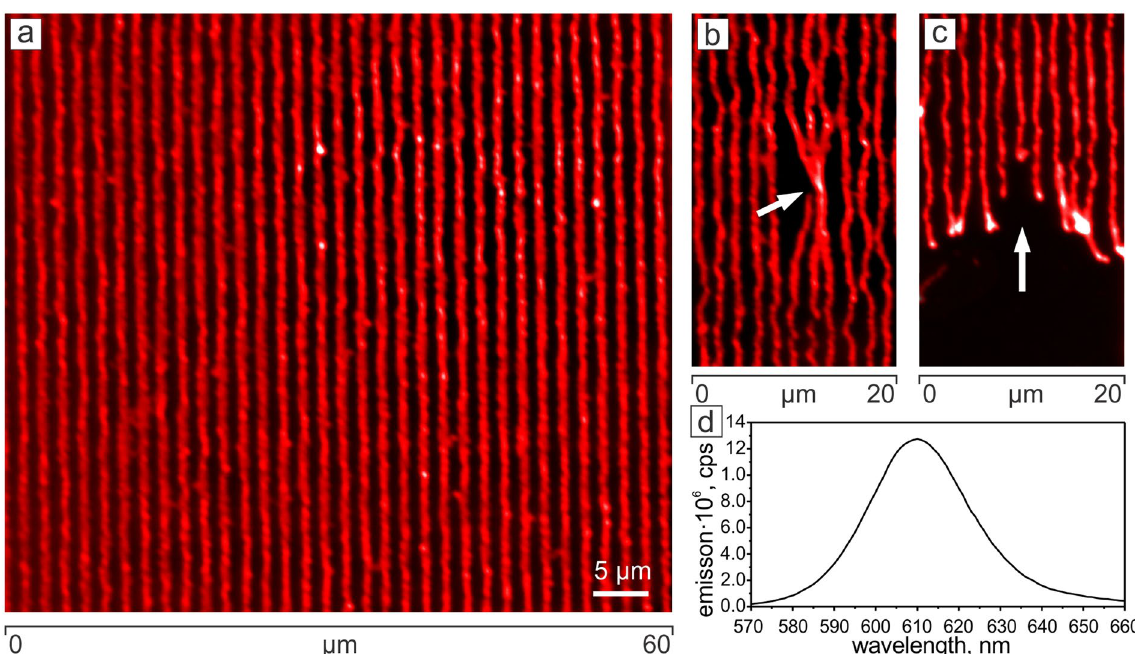
Figure 8. Fluorescent microscopy image of the polymer nano-wires filled with quantum dots. The QDs emit at 610 nm (see plot in d) that results in the red color of the nano-wires. ( a ) shows an ensemble of parallel ordered free standing nano-wires. ( b , c ) There are few defects in the ensemble where three nano-wires form a bundle at one point marked by arrow in ( b ), or they are ruptured forming a fringe as shown in ( c